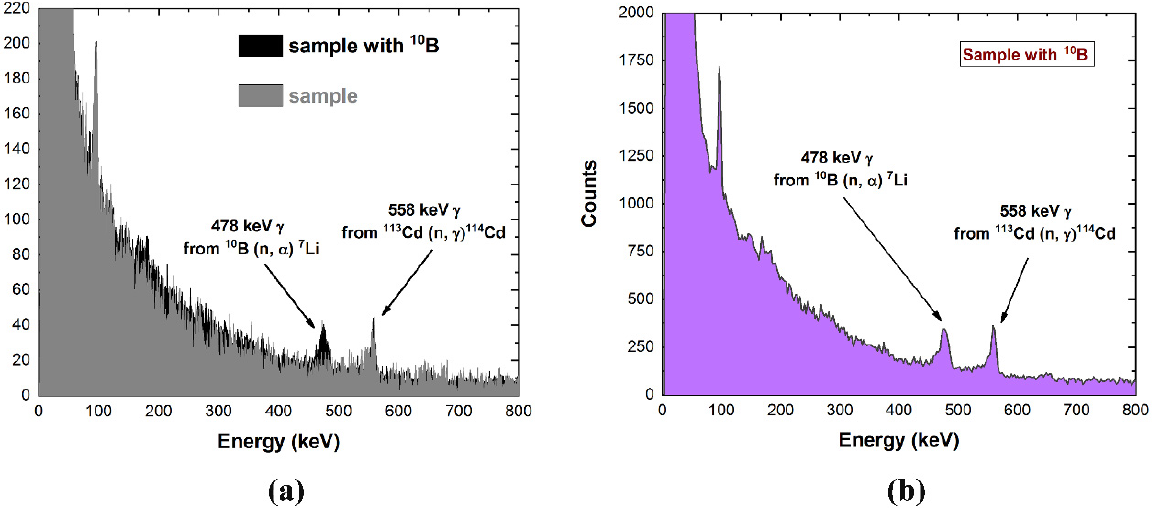
Figure 7. Gamma-ray energy spectra measured with the CZT drift strip detectors in a BNCT environment. ( a ) A comparison between the presence (black line) and the absence of 10 B (gray line). ( b ) The measured energy spectrum with higher counting statistics. The flat top of the 478 keV peak highlights the Doppler broadening effect. We used the spectral correction described above.